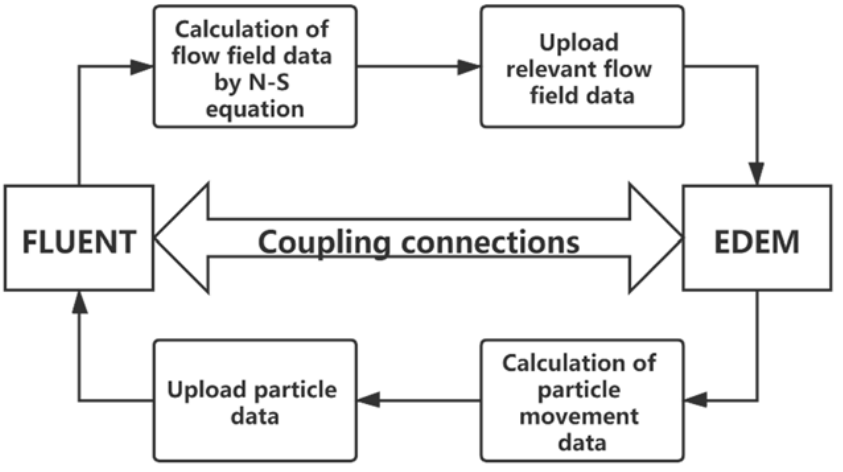
Figure 3. Schematic diagram of CFD-DEM coupling method.